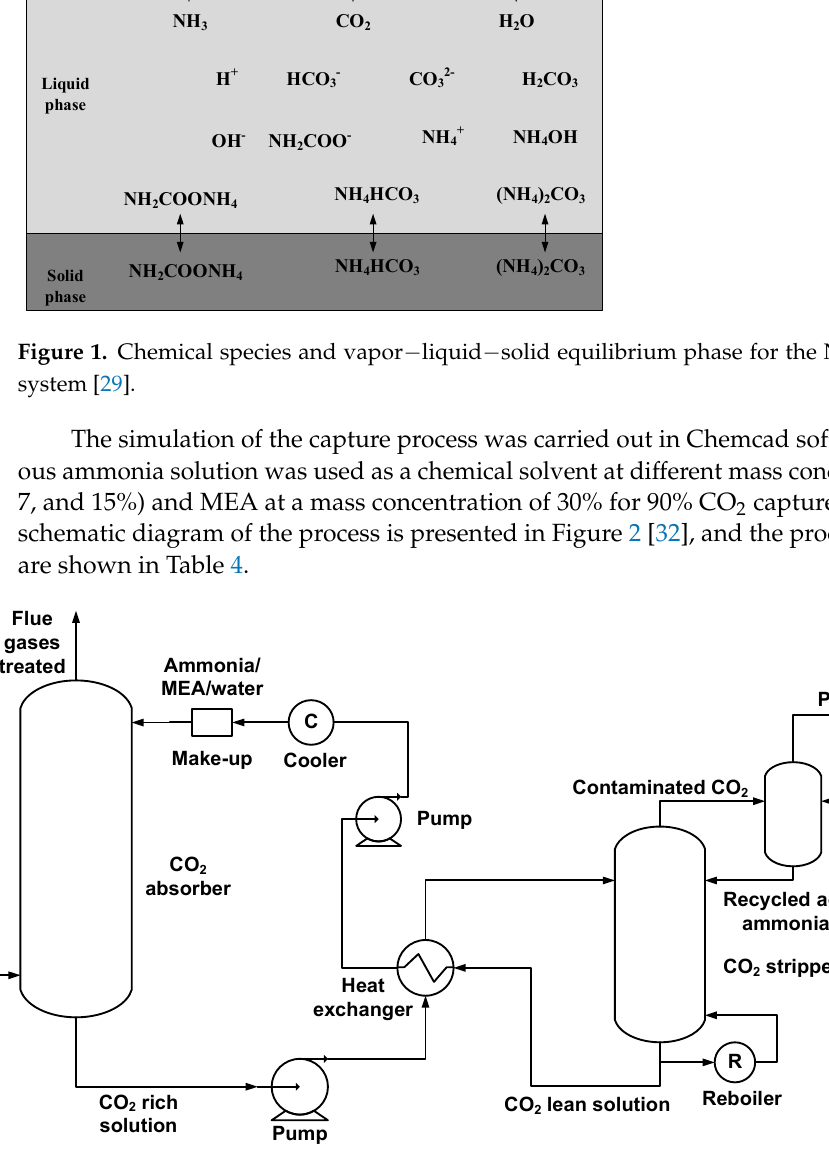
Figure 2. Schematic diagram of the chemical absorption capture process [32]. “Reproduced with permission from [Nela Slavu, Cristian Dinca, Adrian Badea], [Scientific Bulletin, Series C: Electrical Engineering and Computer Science]; published by [Ecaterina Andronescu], (2019)”.